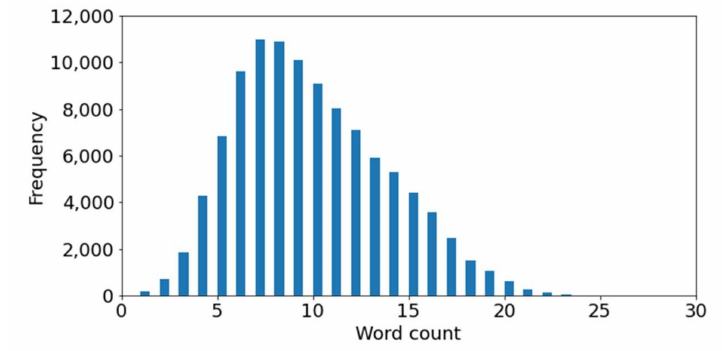
Figure 2. Dataset word distribution.